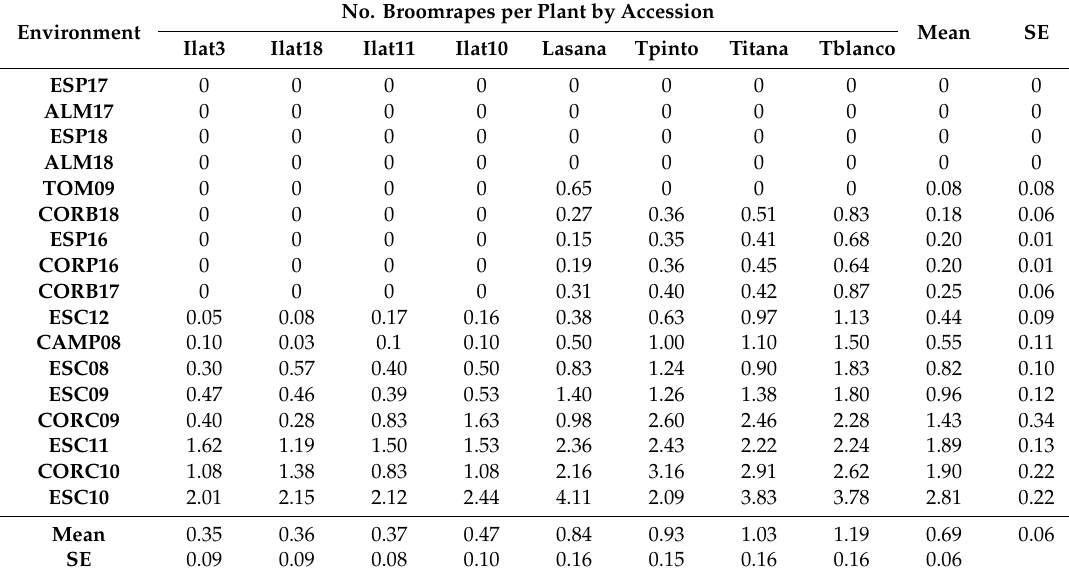
Number of broomrapes per plant on 8 grass pea accessions grown at 17 location–year